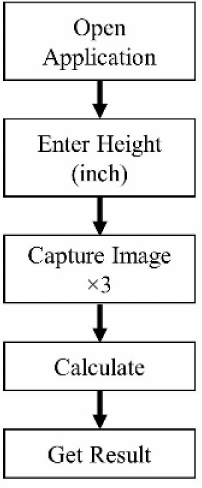
Figure 1. Flowchart of our proposed algorithm.